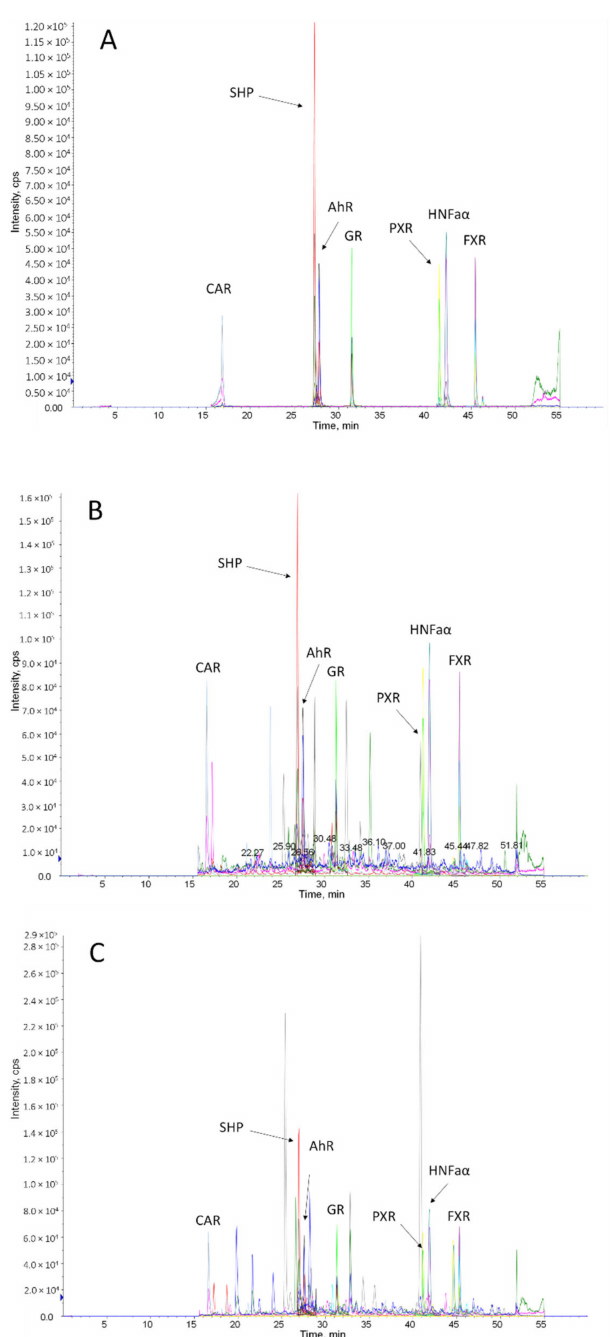
Figure 1. Total ion chromatogram of a digested HSA (validation matrix) sample ( A ), a human jejunum ( B ) and a human liver sample ( C ) spiked with internal standard peptides for all investigated nuclear receptors (each 5 nmol/L). Annotations indicate the respective nuclear receptor